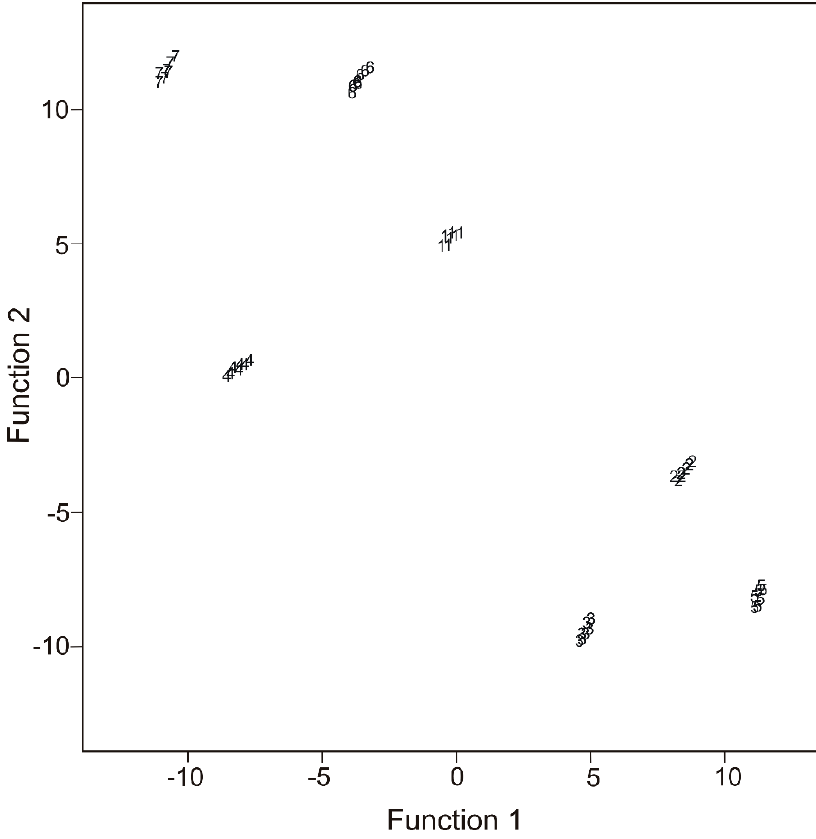
Figure 4. The results of the discriminant factor analysis (DFA) model.